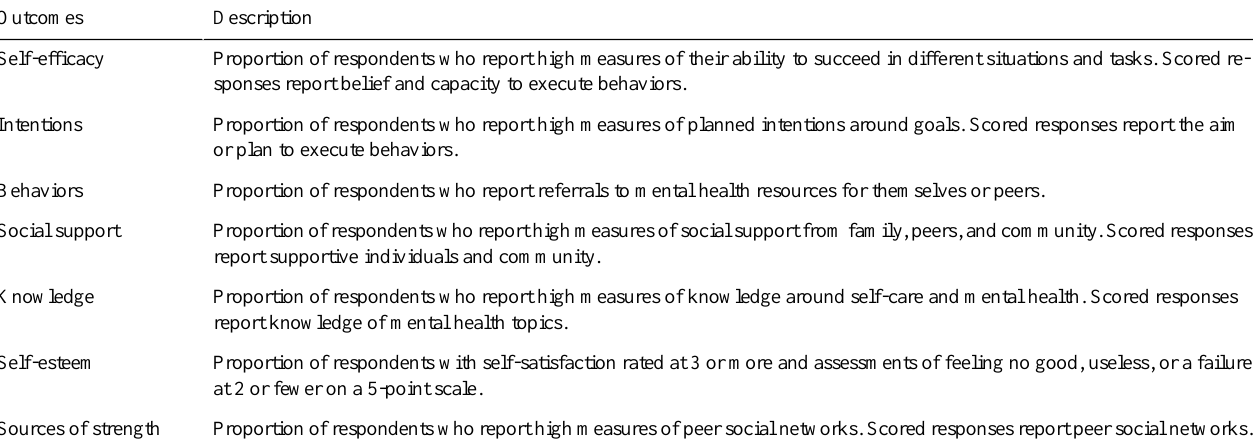
Table 1. Description of youth self-report survey